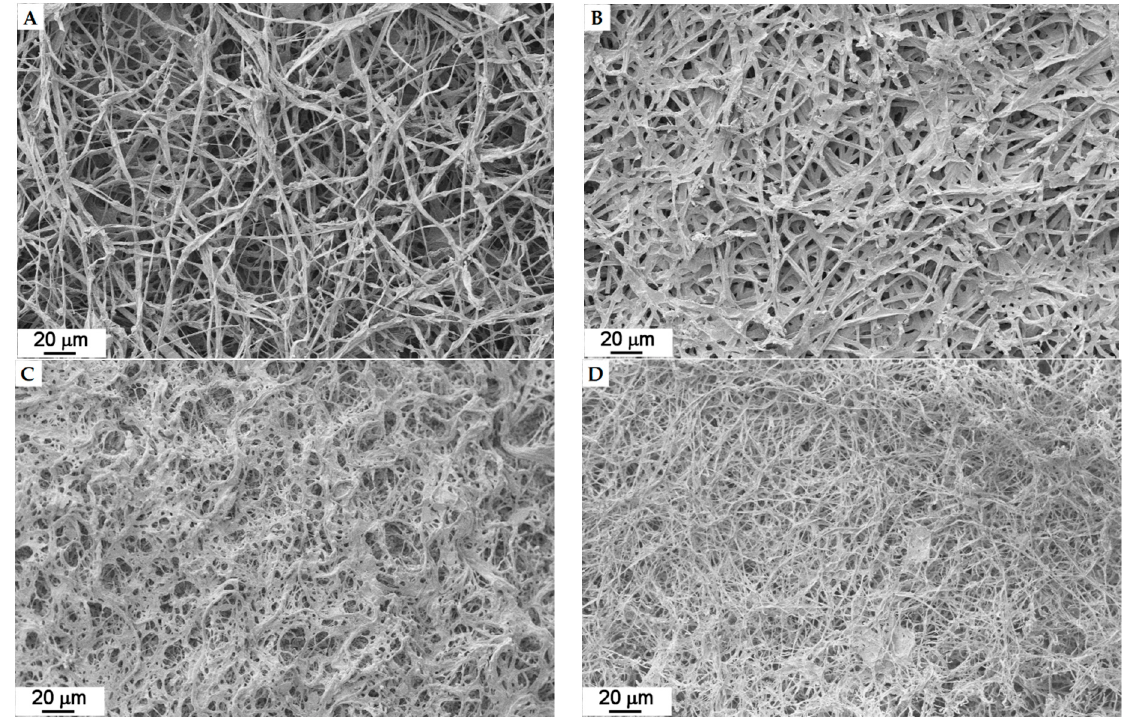
Figure 9. Different kinds of mycelia in strains: ( A ) Coriolopsis trogii (5), ( B ) Irpex lacteus (14), ( C ) Daedaleopsis confragosa (6), and ( D ) Fomitopsis iberica (10).